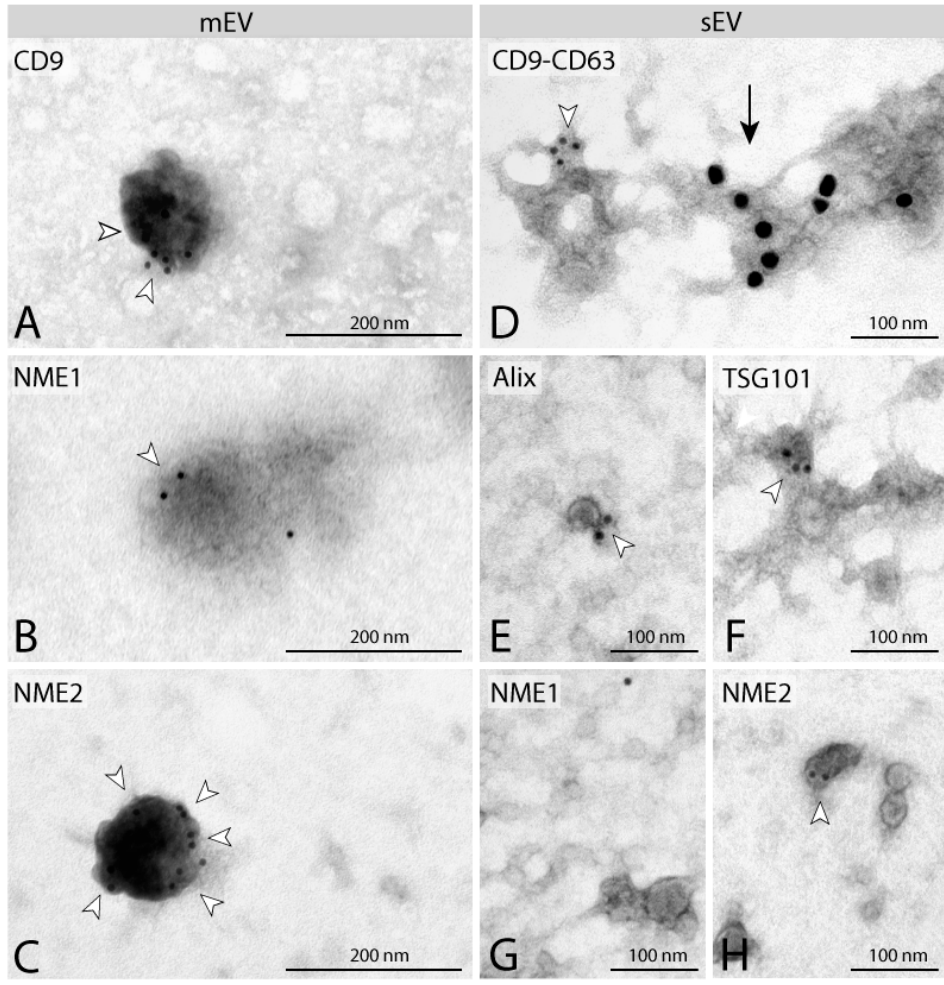
Figure 2. Characterisation of separated EVs by immunoelectron microscopy. Immuno-localisation of tetraspanins (CD9, CD63) on mEVs ( A ) and sEVs ( D ). EV markers Alix ( E ) and TSG101 ( F ) are present on sEVs. Identification of NME1 and NME2 on mEVs ( B , C ). NME1 cannot be detected on sEVs ( G ), whereas NME2 staining can be observed on sEVs ( H ). Gold particles are indicated by white arrowheads (10 nm) and black arrow (20 nm). mEVs and sEVs stained positive for EV markers CD63, CD9, Alix and TSG101 ( A , D – F ) were isolated from MDA-MB-231T cell line expressing the control vector pCDNA. NME1-positive mEVs ( B ) and NME1-negative sEVs ( G ) were isolated from F::NME1 overexpressing cells, whereas NME2 positive mEVs ( C ) and sEVs ( H ) are derived from M::NME2 overexpressing MDA-MB-231T cells.